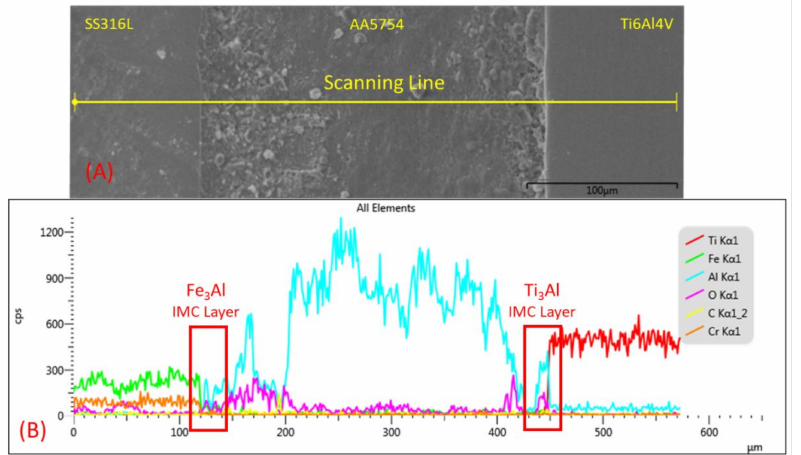
Figure 14. Fe, Al, and Ti distributions across the SS–Al–Ti joint interface from sample 1: ( A ) EDX scanning line; ( B ) chemical composition along the scanning line